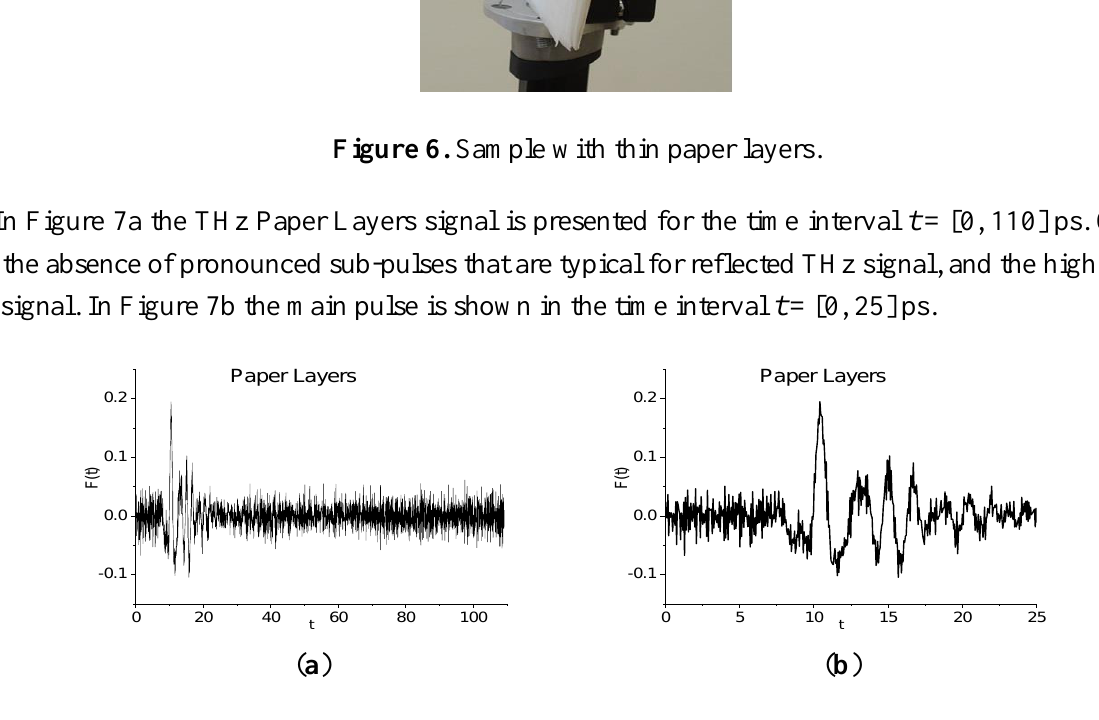
Figure 7. THz Paper Layers signal in the time interval t = [0, 110] ps ( a ); [0, 25] ps ( b